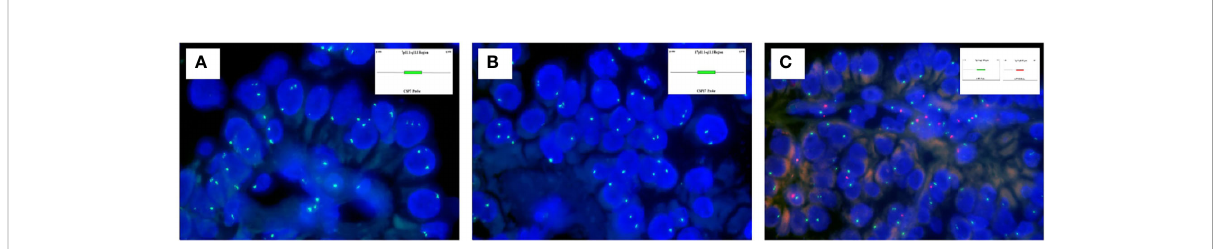
FIGURE 6 Fluorescence in-situ hybridization fi ndings of PRNRP. (A) Trisomy 7 (case 1). Inset indicating the schematic diagram of the centromere-speci fi c probe of chromosome 7. (B) Trisomy 17 (case 1). Inset indicating the schematic diagram of the centromere-speci fi c probe of chromosome 7. (C) Deletion of chromosome Y (case 13). Insets indicating schematic diagrams of the centromere-speci fi c probe of chromosome X (green) and chromosome